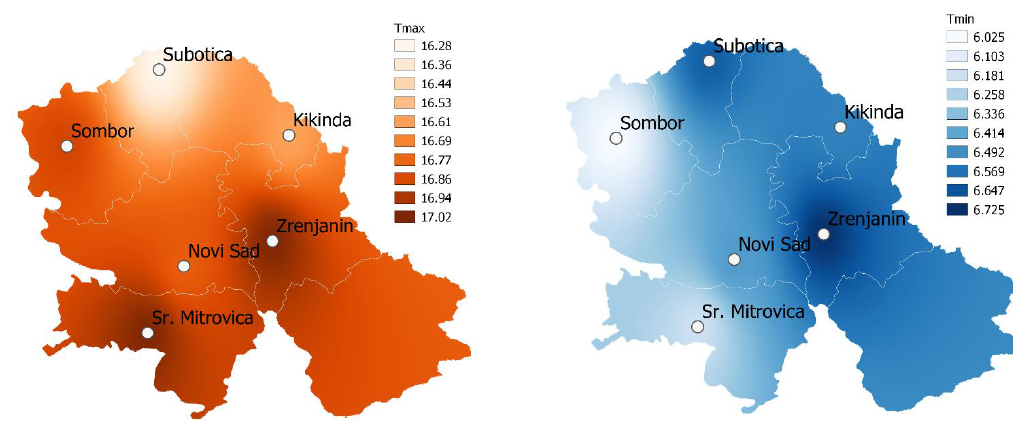
Figure 4. Mean T max and T min for the period 1981–2010 in Vojvodina (RHMSS) (data for station Vrsac were not available and presented data are a product of interpolation). Table 2. The average seasonal anomaly of T max and T min for four selected climatological stations in respect to mean T max and T min for the 1981–2010 period (station Vrsac is not included since data were not available for this entire climatological